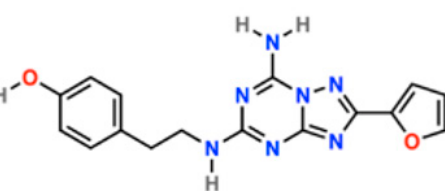
Figure 2. ZMA chemical structure, drawn with Maestro [33].